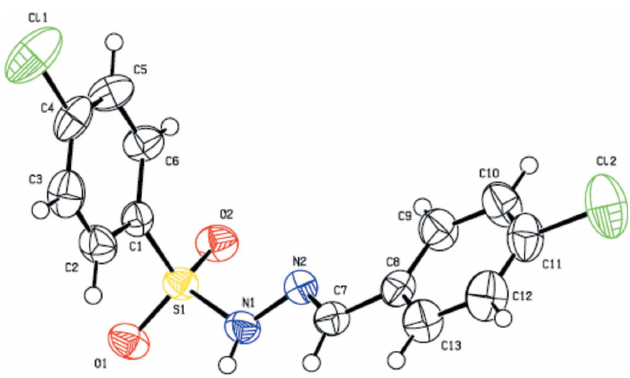
Figure 1 Molecular structure of (I), with the atom labelling and displacement ellipsoids drawn at the 50% probability level.